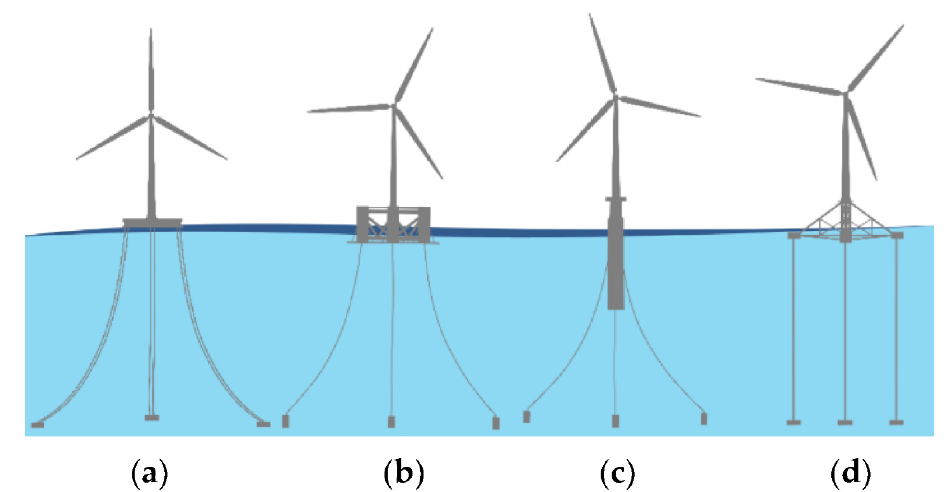
Figure 3. Types of Floating Offshore Wind Turbines: ( a ) Barge; ( b ) Semisubmersible; ( c ) Spar; ( d ) TLP